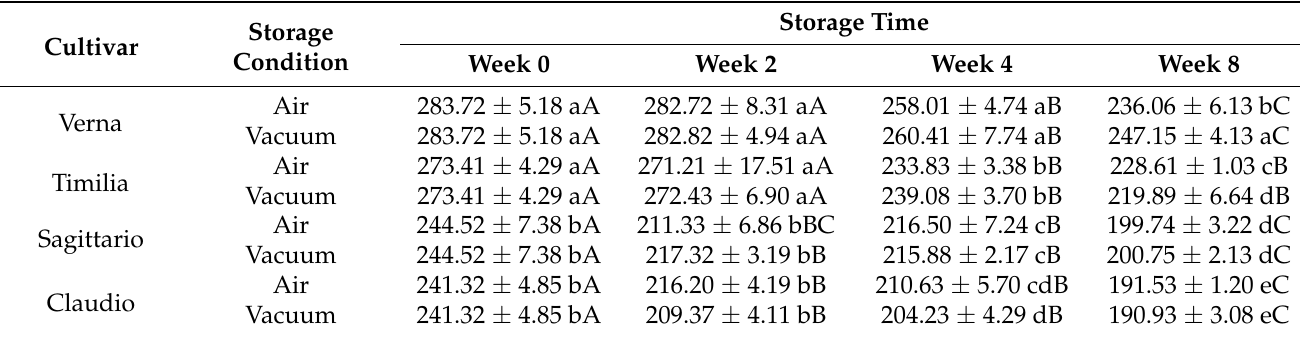
Table 2. Total polyphenol contents expressed as gallic acid equivalents of four wheat cultivars (mg/100 g) stored under different conditions and lengths of time.